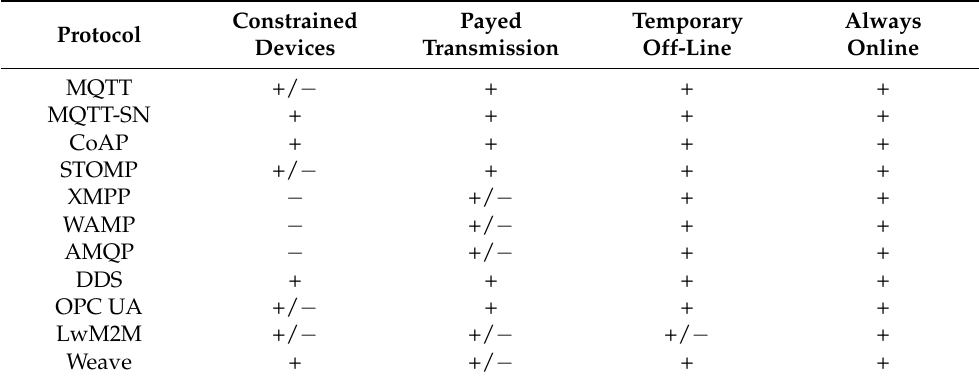
Table 4. Suitability for selected types of IoT